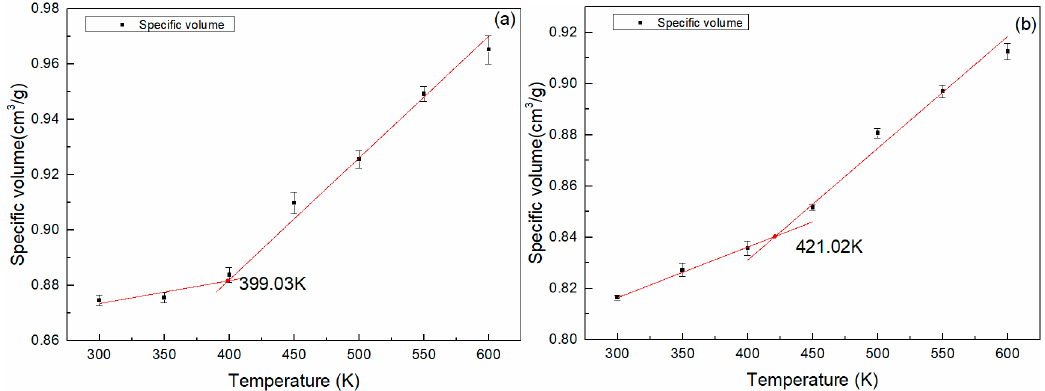
Figure 11. The specific volume-temperature fitting curves of epoxy resins. ( a ) DGEBA-MTHPA; ( b ) DGEBA-NA.